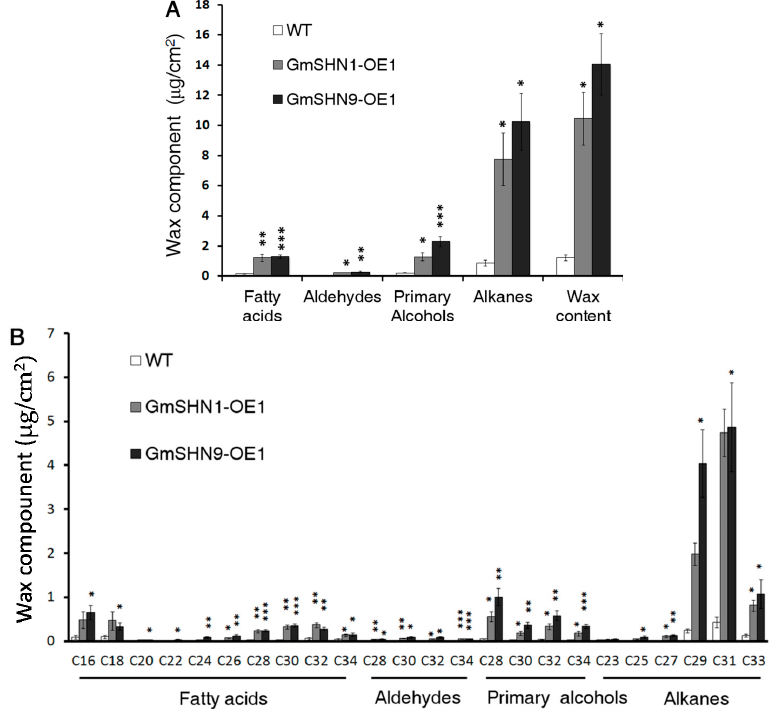
Figure 8. Analysis of leaf cuticular wax contents and components of GmSHN1-OE1, GmSHN9-OE1, and WT. ( A ) Quantitative analysis of wax contents and components in Arabidopsis leaves;